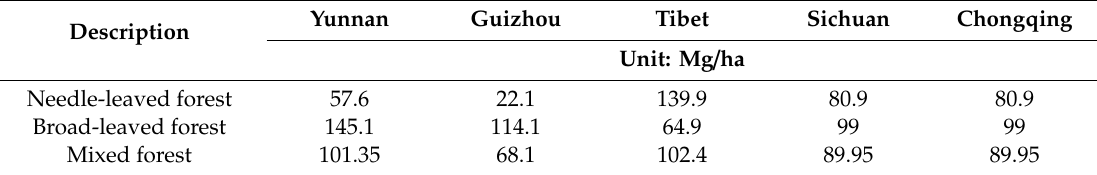
Table 1. Aboveground biomass density assigned at the provincial level in China.